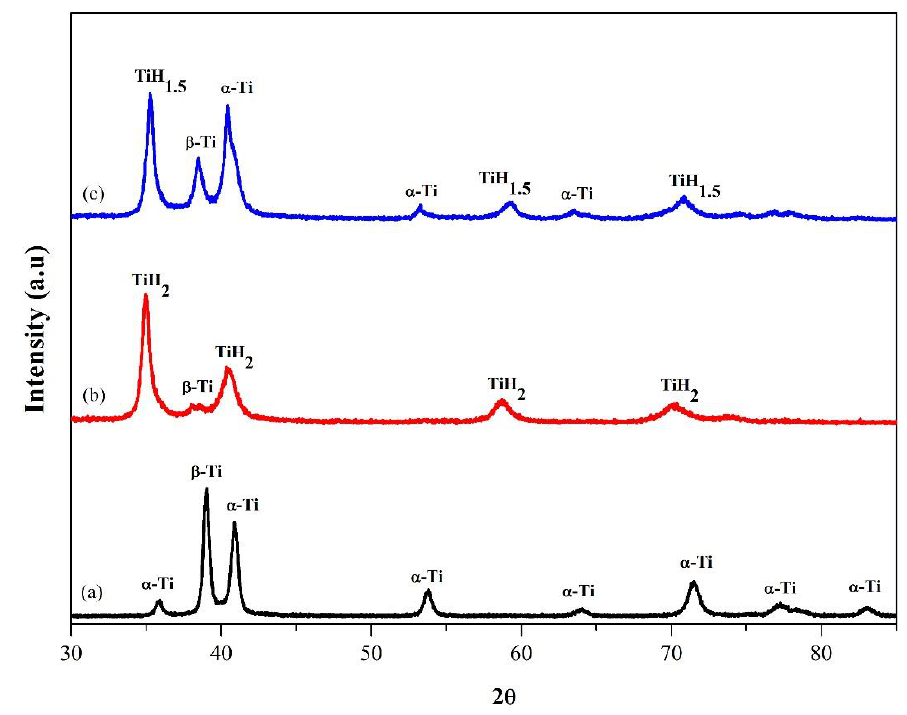
Figure 6. X-ray diffraction analysis of the raw material ( a ), after hydrogenation ( b ), and after dehydrogenation ( c ).